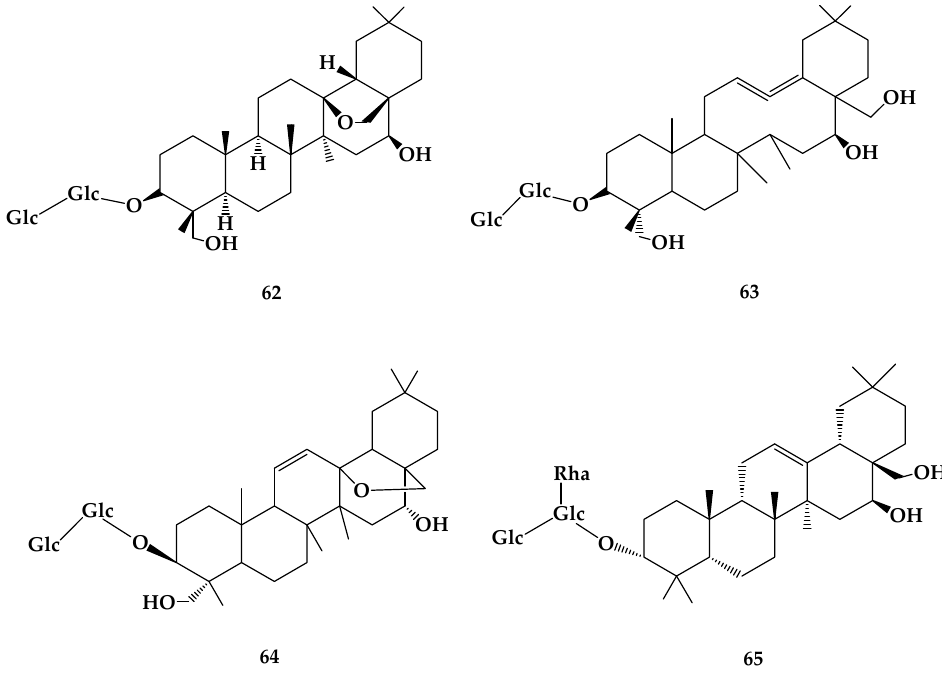
Figure 12. The chemical structures of compound 62 – 65